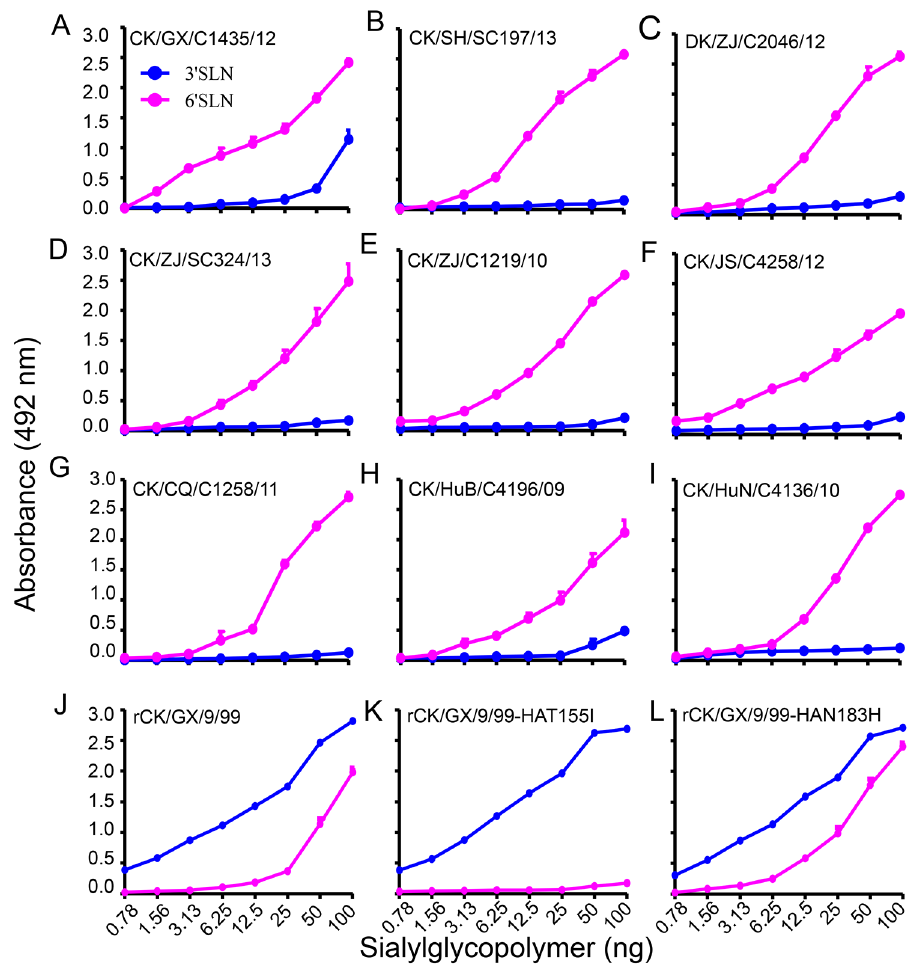
Figure 2. Characterization of the receptor-binding properties of H9N2 viruses. The binding of the viruses to two different biotinylated glycans ( a -2, 3 glycan, blue; a -2, 6 glycan, pink) was tested. The data shown are the means of three repeats; the error bars indicate the standard deviations. ( A ) CK/GX/C1435/12. ( B ) CK/SH/SC197/13. ( C ) DK/ZJ/C2046/12. ( D ) CK/ZJ/SC324/13. ( E ) CK/ZJ/C1219/10. ( F ) CK/JS/C4258/12. ( G ) CK/CQ/ C1258/11. ( H ) CK/HuB/C4196/09. ( I ) CK/HuN/C4136/10. ( J ) rCK/GX/9/99. ( K ) rCK/GX/9/99-HAT155I. ( L )